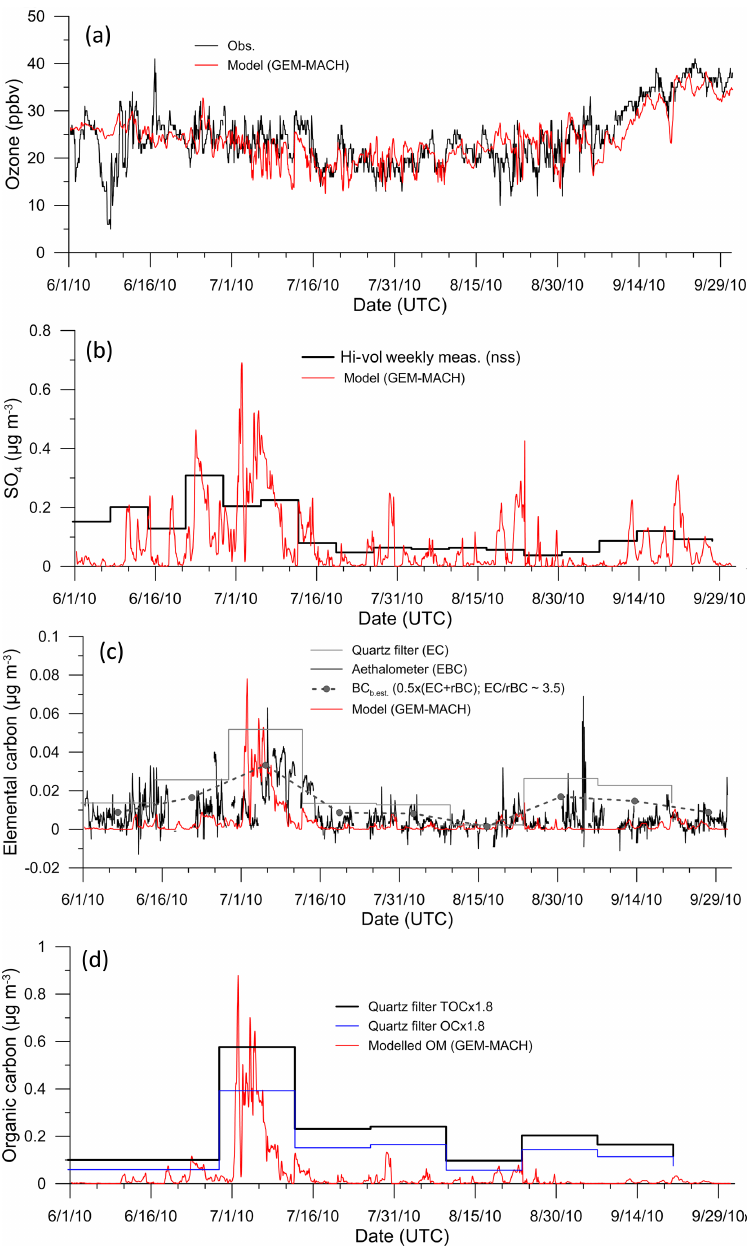
Figure 8. Comparison with observations at the Alert site for June–September 2010: (a) O 3 , (b) sulfate; nss denotes non-sea-salt, (c) EC, and (d) OC